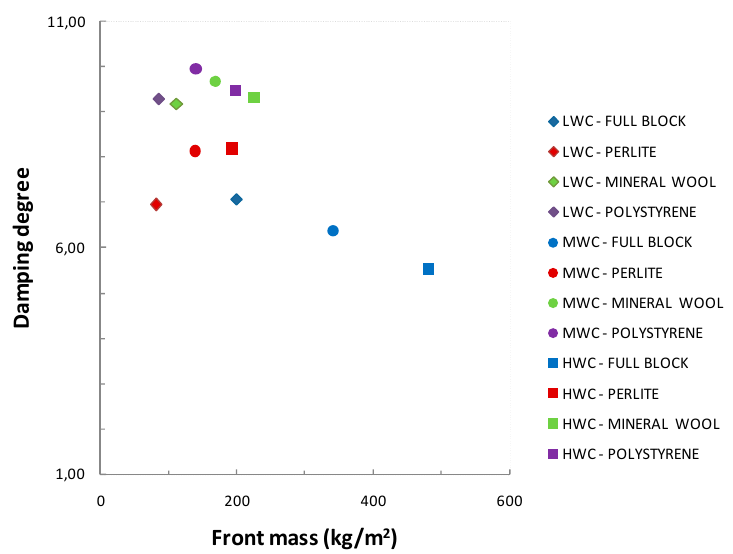
Figure 8. Damping degree vs. front mass, all material combinations.